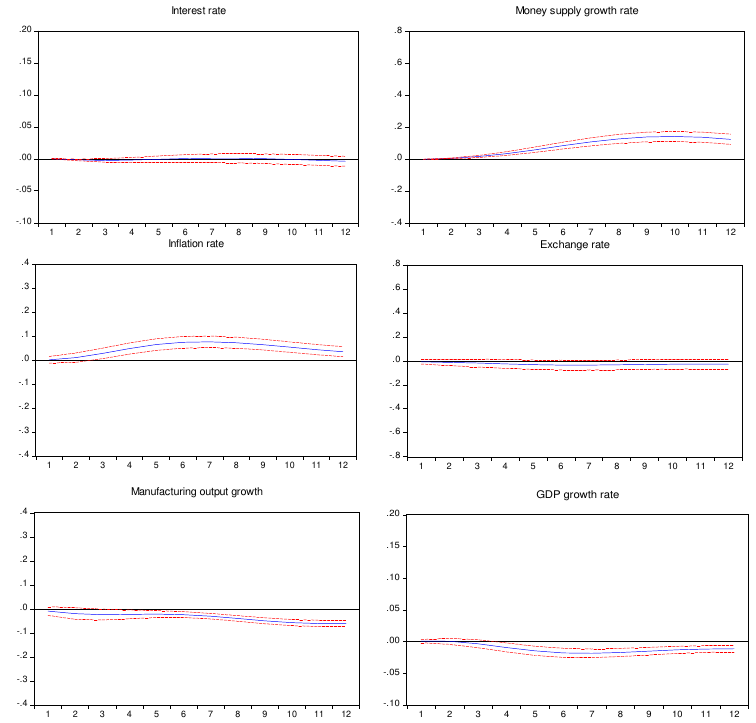
Figure 2. Responses of selected variables to an oil output growth rate shock in Algeria